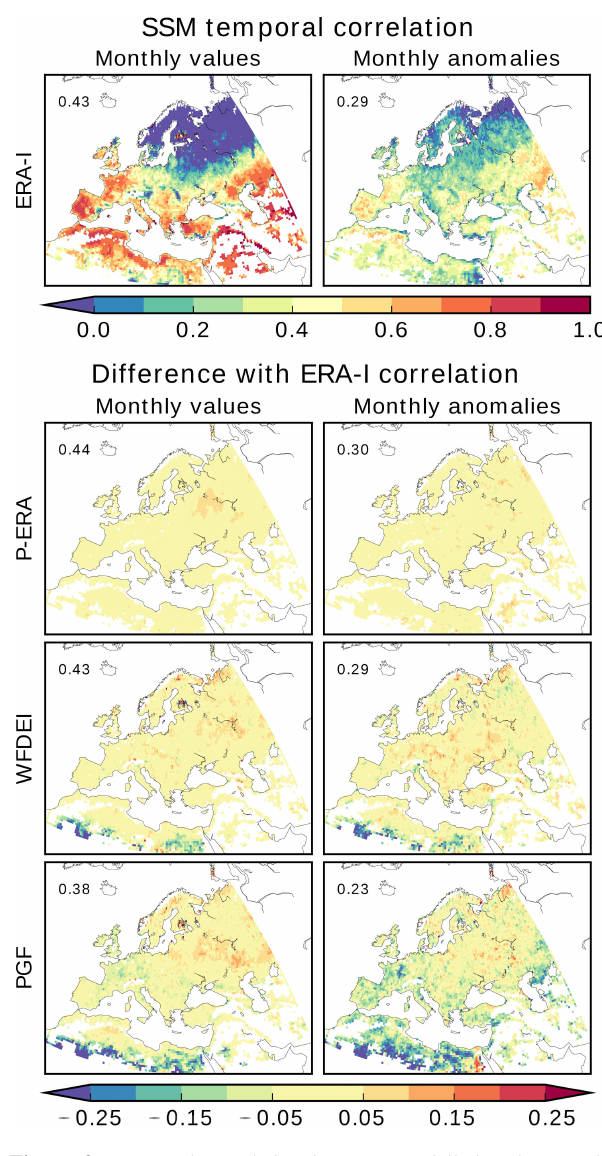
Figure 3. Temporal correlation between modelled and remotely sensed ESA-CCI SSM for monthly averages and anomalies. Global correlation coefficients are reported in the upper left corner of each